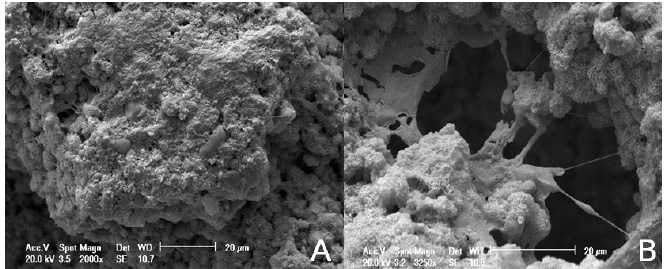
FIGURE 4 - Scanning electron micrography of cells adhered on the macroporous CPC surface on the tenth day of culture. A) Magnification of 2000x, B) Magnification of 3250x.